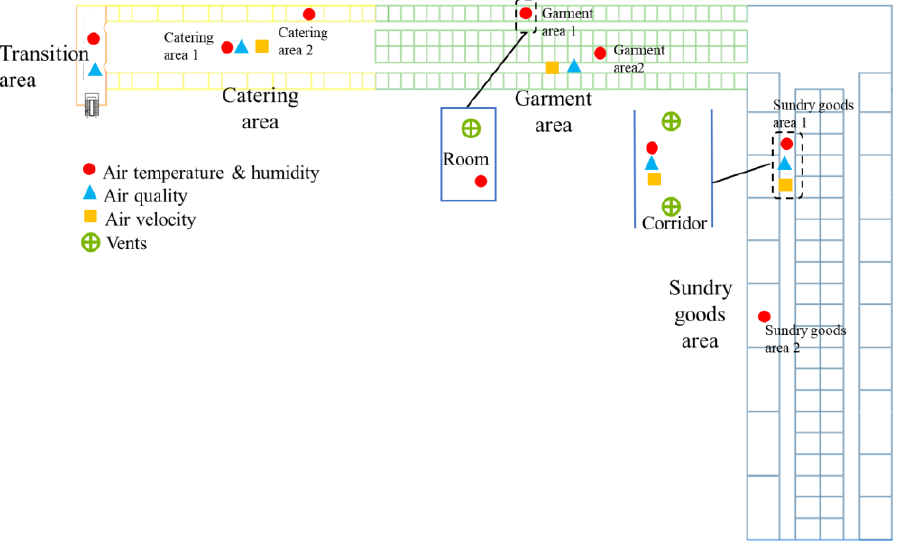
Figure 1. Arrangement of measuring points in the underground shopping mall.